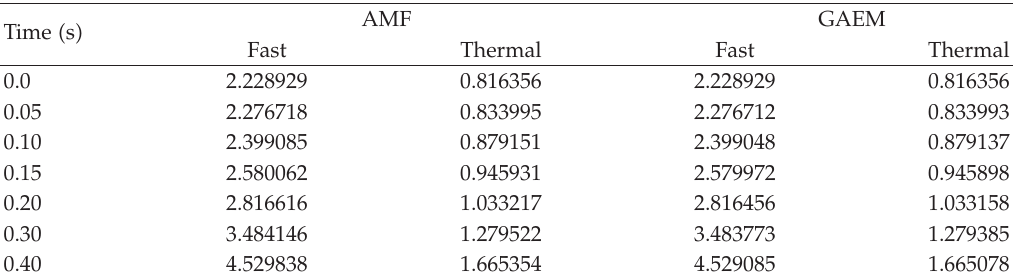
Table 4: Neutron flux at the center point of three dimensional homogeneous reactor with a positive ramp reactivity.